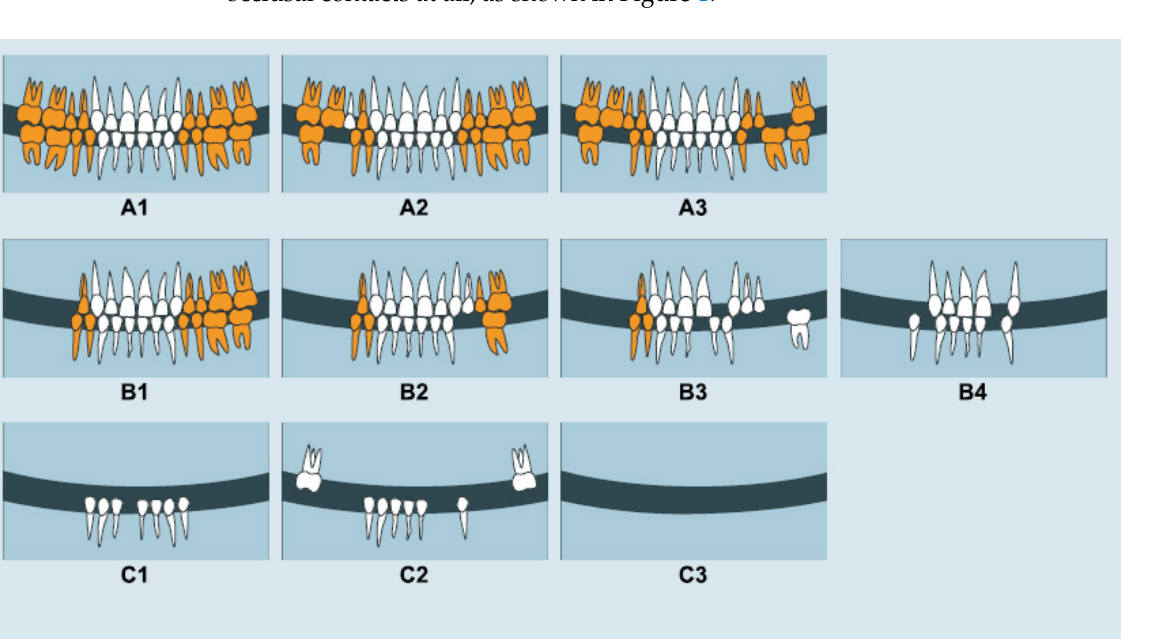
Figure 1. Eichner’s index, where the yellow marked teeth belong to the premolar and molar regions. A have occlusal contacts in all four posterior support zones ( A1 – A3 ); B (have occlusal contacts in one to three zones or within the anterior area only ( B1 – B4 ); and C have no occlusal contacts at all ( C1 – C3 ). The picture was taken with permission from one of the author’s thesis (AL): tooth loss and prosthetic replacements among persons with dependency and functional limitations. https://openarchive.ki.se/xmlui/bitstream/handle/10616/46169/Thesis_Angelika_Lantto.pdf?sequence=1&isAllowed=y (accessed on 23 February 2022).